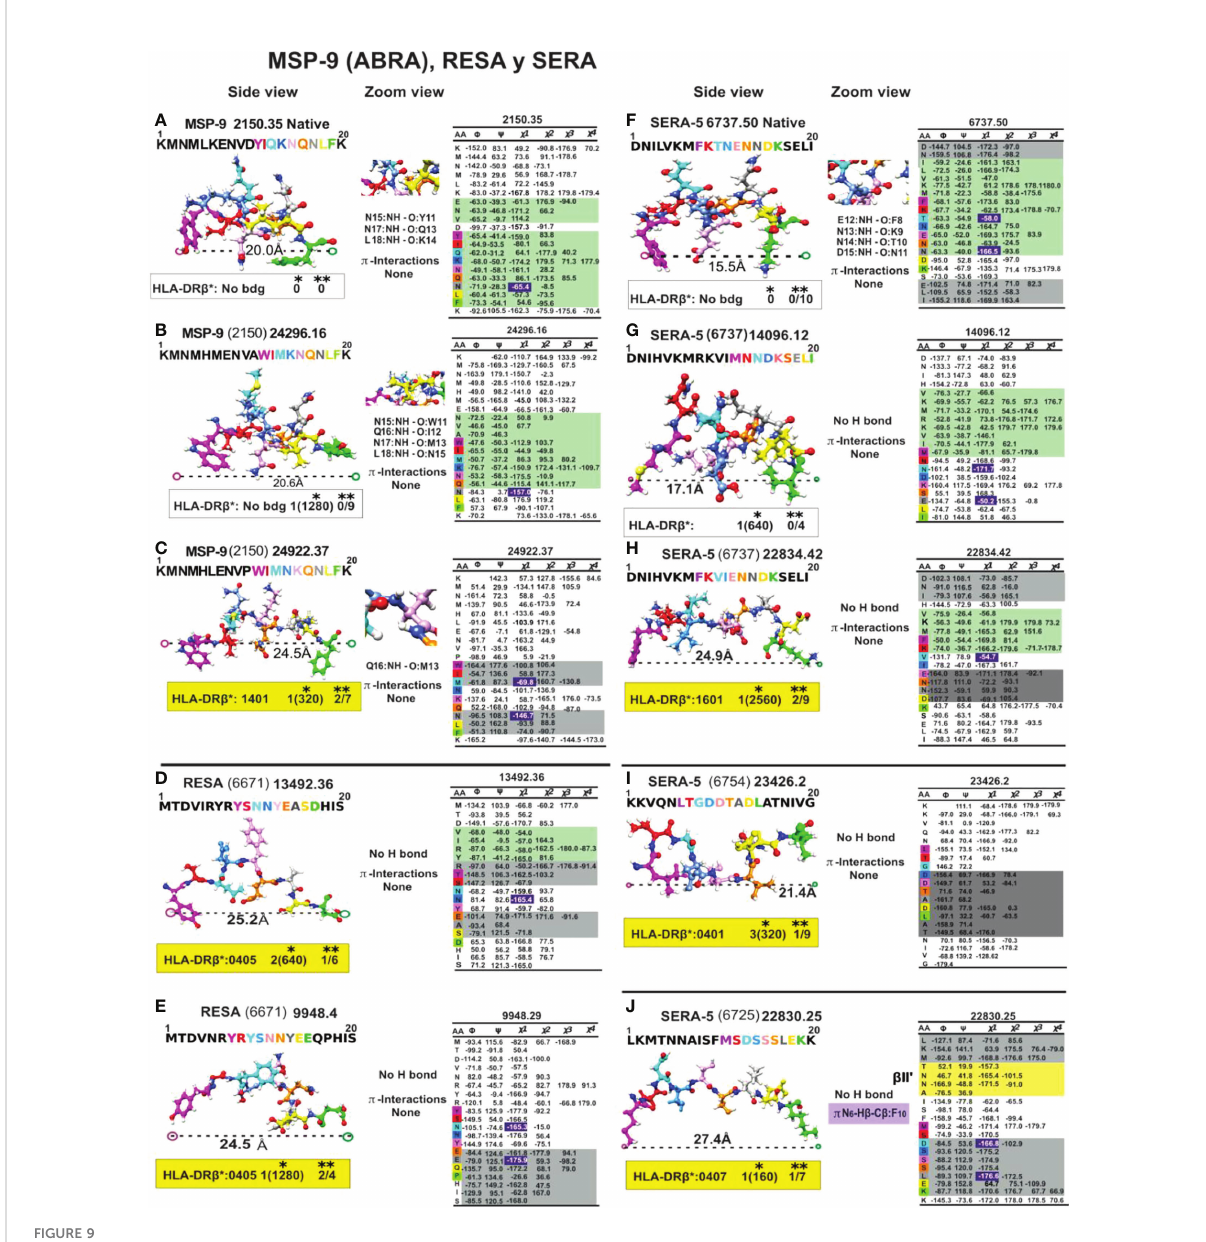
FIGURE 9 Colour code for peptide binding region, structural and interaction as in Figure 8. (*) Nr Monkeys (antibody titers) and (**) Nr of protected monkeys. MSP-9-, RESA- and SERA-derived cHABP and mHABPs. Legend and conventions as in Figure